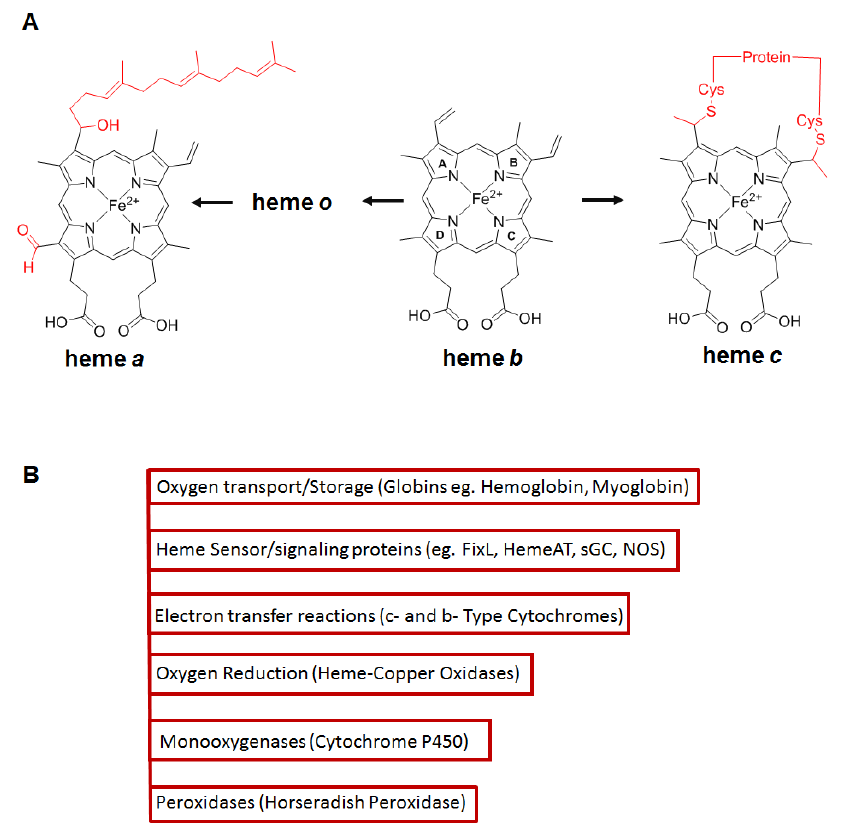
Figure 2. ( A ) Structures for heme a, b and c. Heme a and c are synthesized from heme b via side chain modifications shown in red. Pyrrole rings nomenclature a, b, c and o are depicted using the Hans Fischer system. ( A ) Adapted from Reference [33]. ( B ) Representative classes of heme proteins which incorporate such hemes.